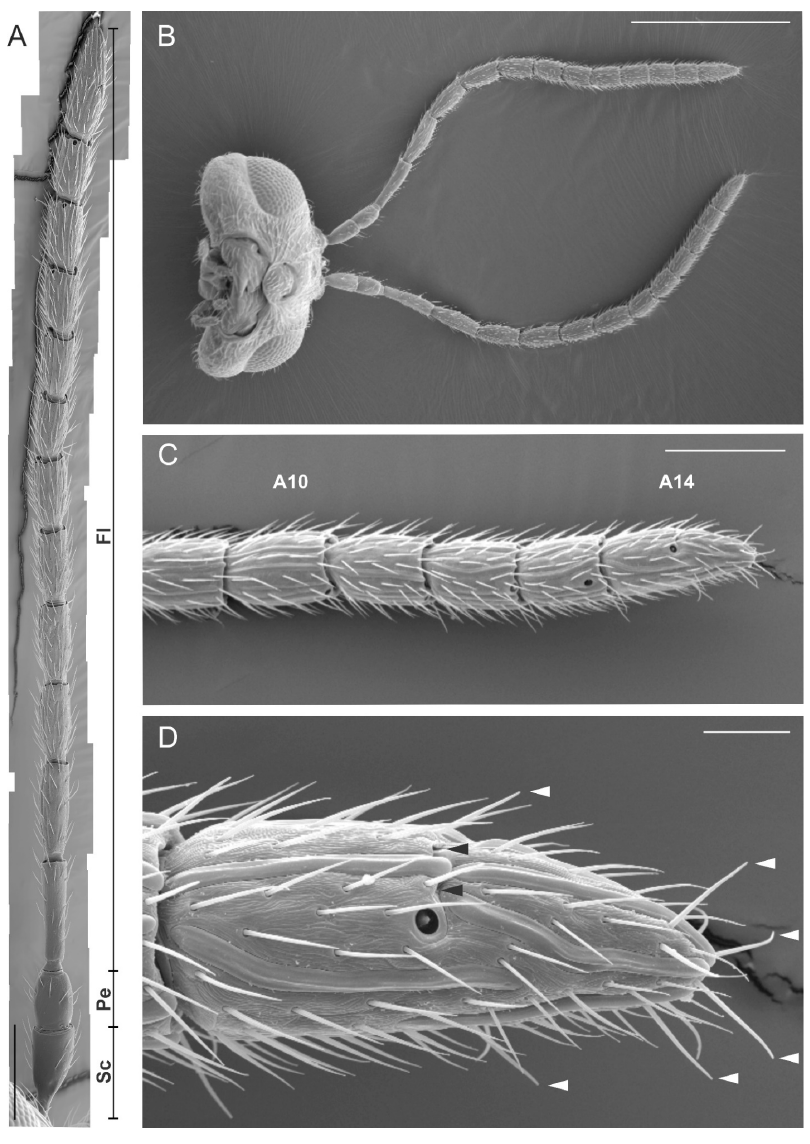
Figure 1. Scanning electron microscopy (SEM) micrographs showing the filiform antenna of Dryocosmus kuriphilus female. ( A ) General view of the antenna showing the scape (Sc), the pedicel (Pe) and the flagellum (Fl). The length (mean ± SD) of each antennomere was: Sc = 90.9 ± 5.1; Pe = 125.9 ± 3.3; Fl1 = 182.3 ± 5.4; Fl2 = 164.8 ± 5.9; Fl3 = 139.6 ± 3.6; Fl4 = 135.7 ± 2.9; Fl5 = 122.2 ± 3; Fl6 = 115.7 ± 2.8; Fl7 = 96.6 ± 2.1; Fl8 = 100.4 ± 2.3; Fl9 = 92.1 ± 3; Fl10 = 88.1 ± 3.9; Fl11 = 83.9 ± 4; Fl12 = 143.3 ± 8.8. ( B ) Ventral view of the head capsule with antennae. ( C ) Close-up view of the apical part of the flagellum (A10–A14). ( D ) Detail of the apical antennomere (A14) characterized by a transverse furrow (black arrowheads) positioned in the medial region of the antennomere. White arrowheads indicate the position of sensilla chaetica. Bar scale: ( A , B ) 500 µ m; ( C ), 100 µ m; ( D ), 20 µ